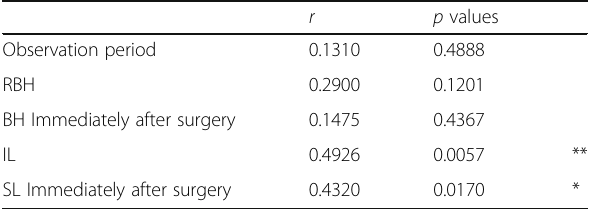
Table 5 Impact of each factor on SL at